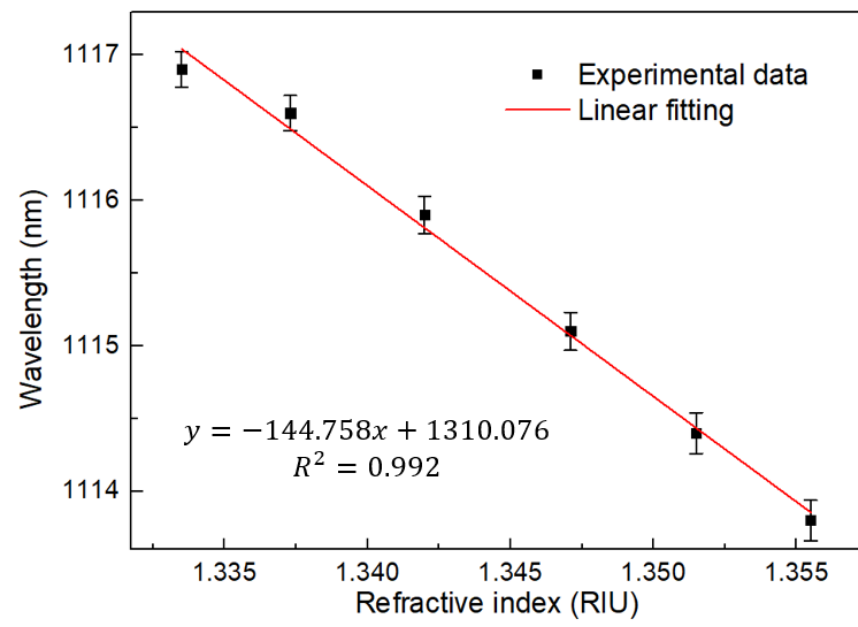
Figure 12. Linear regression curve of RI with wavelength at BBS.